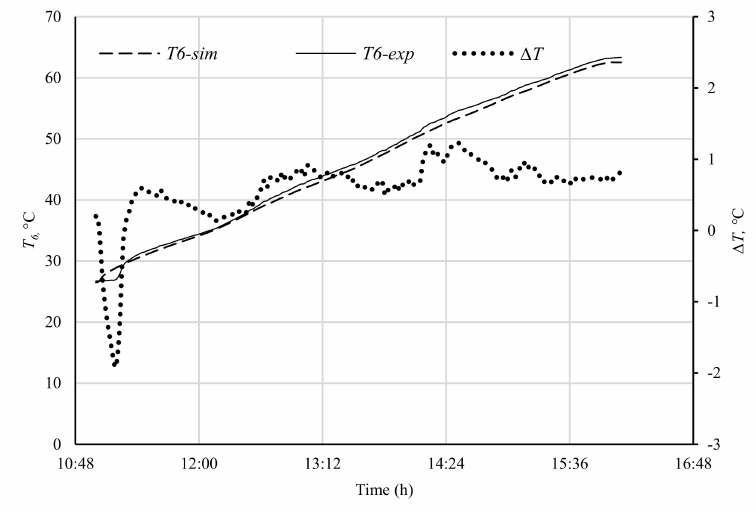
Figure 7. Storage tank experimental–simulated comparative, 17/July/2020.